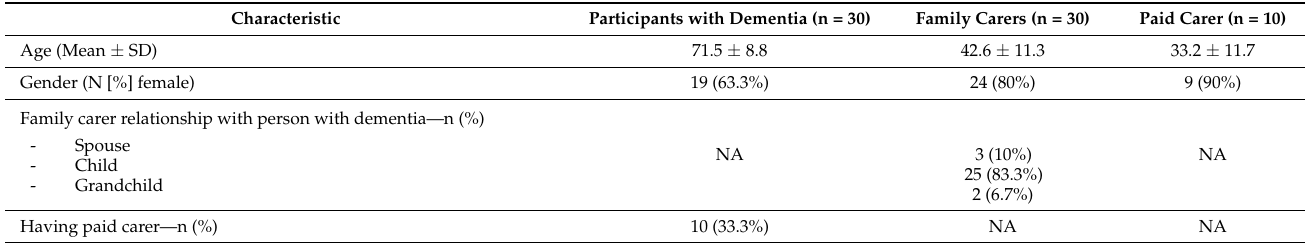
Table 2. Characteristics of the participants at